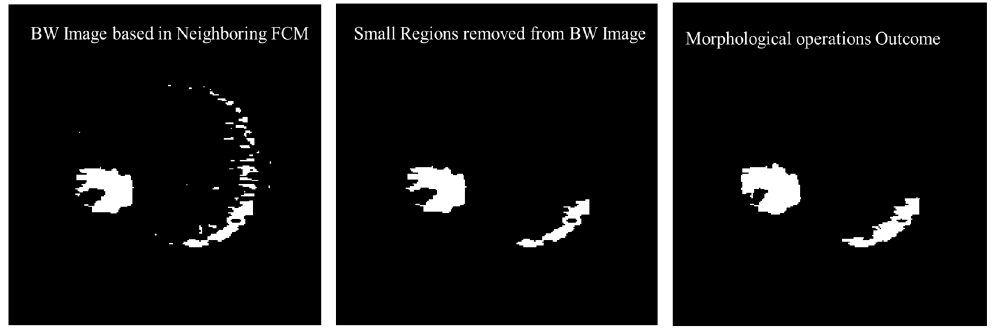
Figure 12. Visual results after removing the small regions from the binary image and applying the morphological operations.